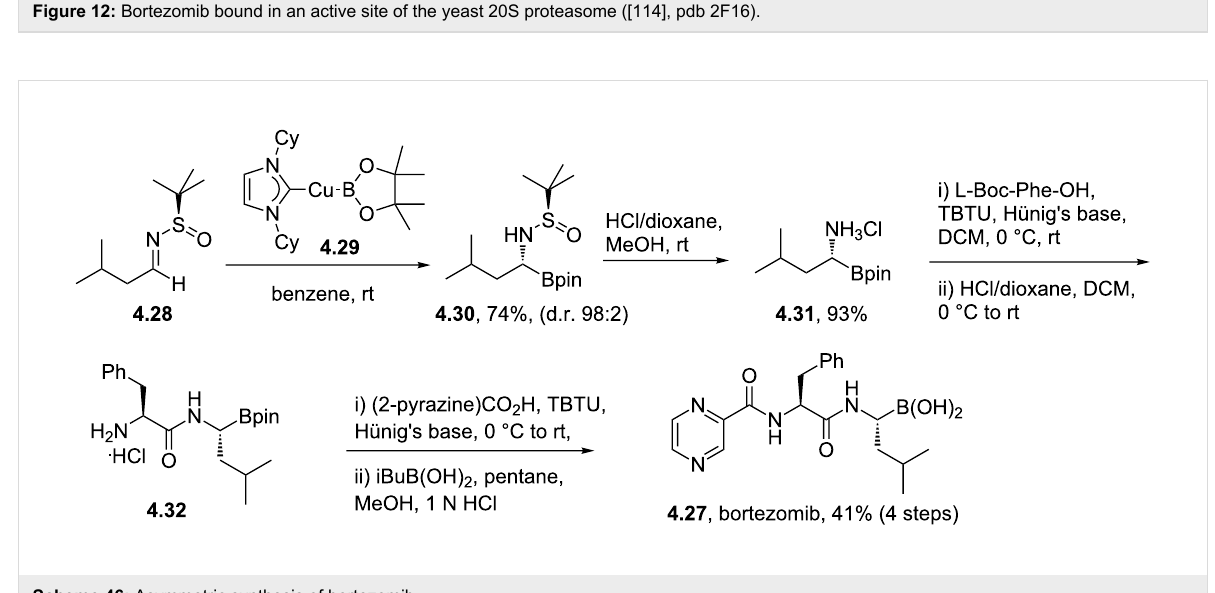
Scheme 46: Asymmetric synthesis of